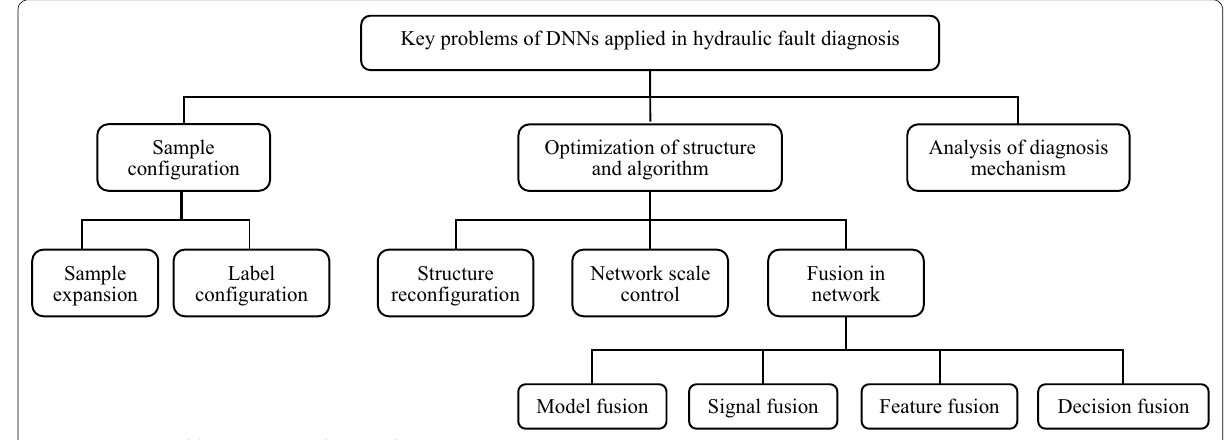
Figure 13 Key problems requiring deep study